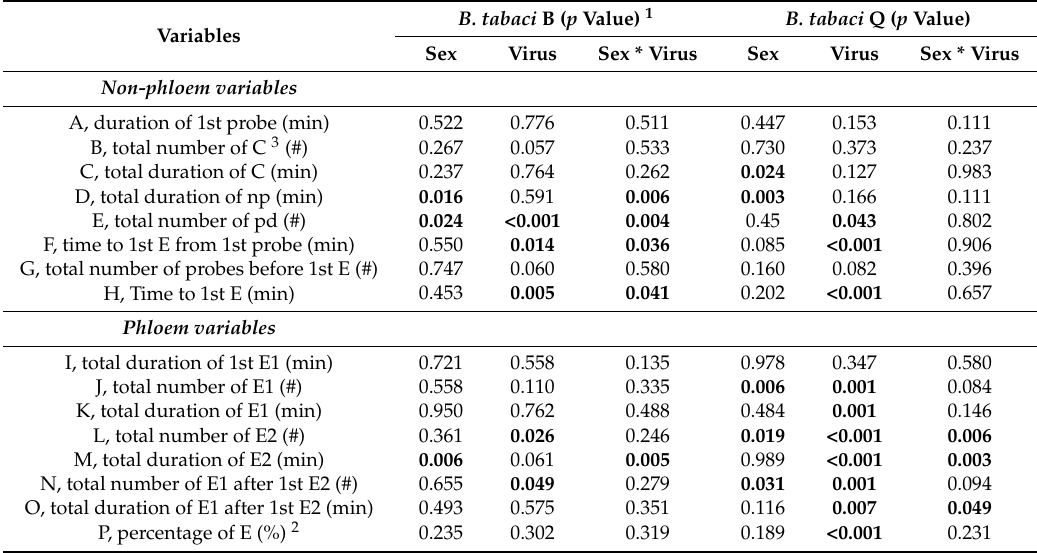
Table 3. Interaction analysis of EPG variables among sexes, viruliferous status and biotypes by two-way analysis of variance